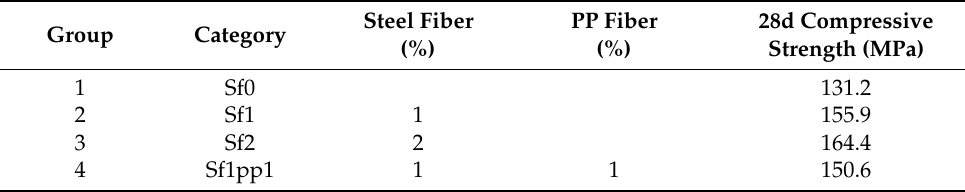
Table 4. Key components of UHPC layer for each repaired system